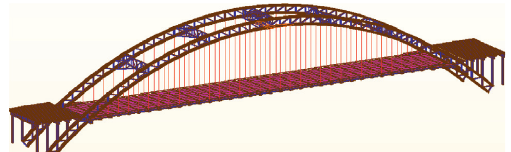
Figure 4: Finite element model of Liujing-Yujiang Bridge.